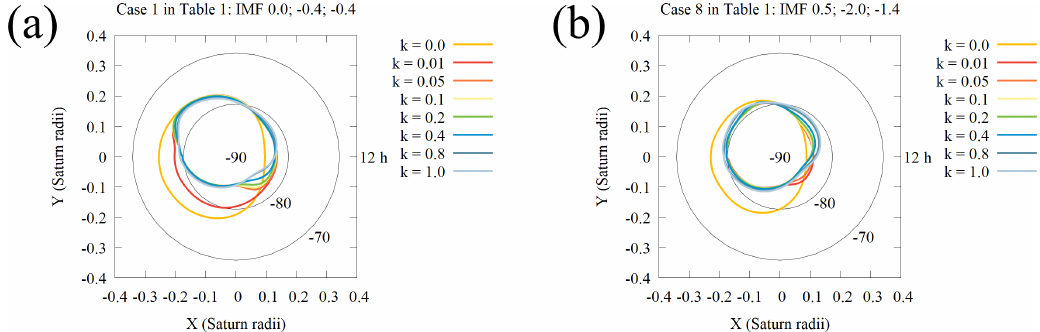
Figure 8. Ionospheric open field line area calculated for cases (a) 1 and (b) 8 (see Table 1) for different values of the IMF penetration coefficient into the Kronian magnetosphere: k = 0 . 0, 0.01, 0.05, 0.1, 0.2, 0.4, 0.8, and 1.0 ( k = 0 corresponds to the partially closed model, k (cid:54)= 0 to the open model).